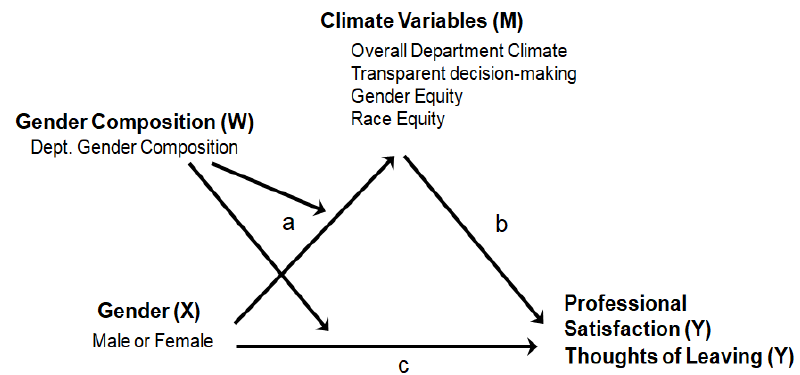
Figure 2. Conceptual model of moderated mediation examining whether gender differences in faculty members’ professional satisfaction/thoughts of leaving as mediated by differential perceptions of departmental climate varies by department gender composition.